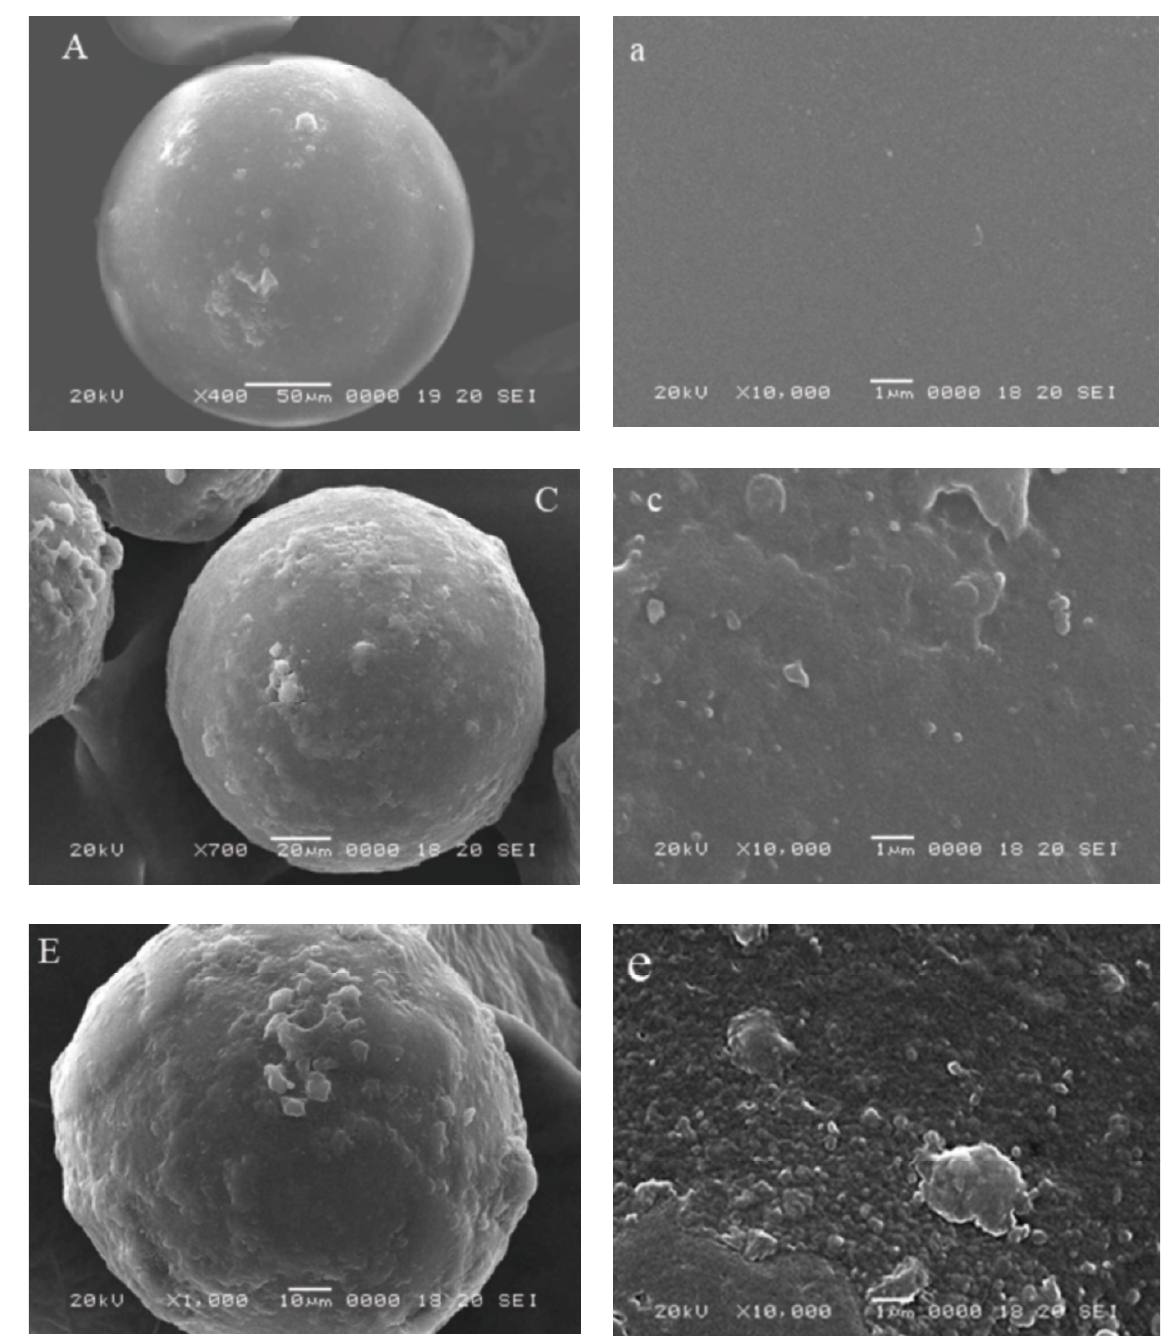
Figure 2. SEM images of the particles (A, a: the silica gel; C, c: SG-PS-NH